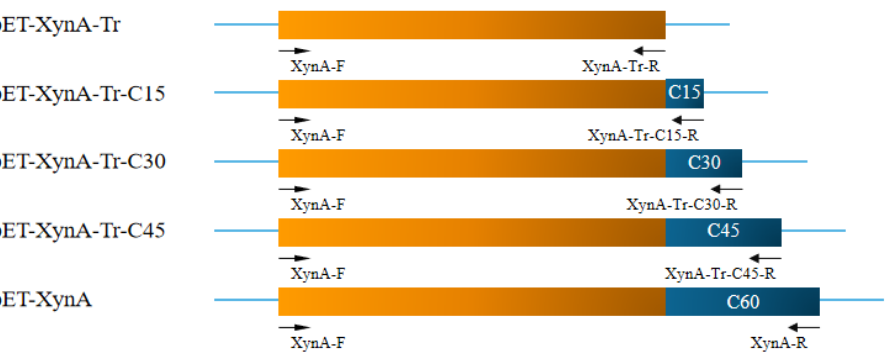
Figure 1. Schematic diagram of the construction of truncated mutants.